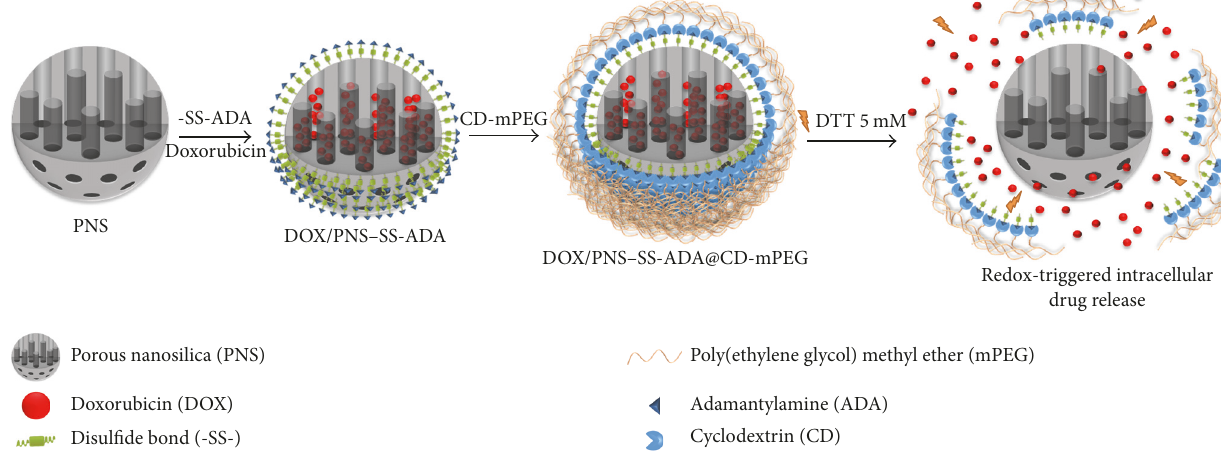
Figure 1: Schematic showing the formation of redox-responsive DOX/PNS-SS-ADA@CD-mPEG